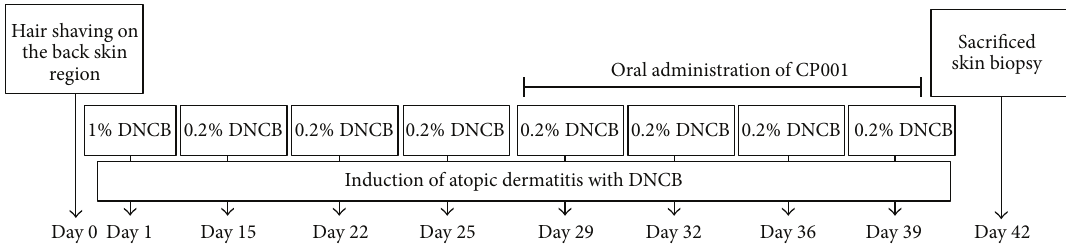
Figure 1: Protocols for induction of atopic dermatitis in mouse model. Shaved dorsal regions of the mice were sensitized with DNCB solution. Male BALB/c mice were epicutaneously sensitized with 200 𝜇 l of a 1% DNCB solution on day 1. Two weeks later, dermatitis was induced with 200 𝜇 l of 0.2% DNCB solution at the intervals shown in the figure. CP001 was orally administrated from the 3rd week during sensitization together with